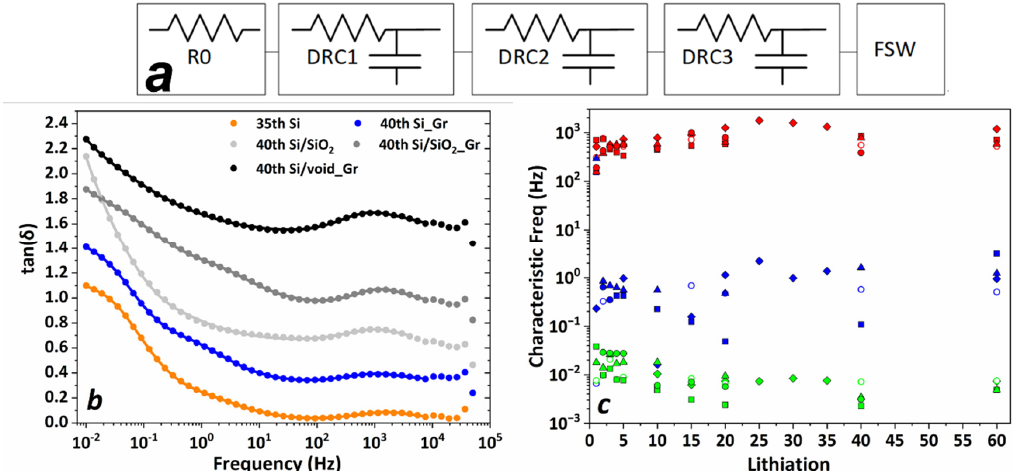
Figure 8. ( a ) Electrical response model for the description of the tan( δ ) data composed by a resistance in series with three distributed RC elements and a finite space Warburg element. ( b ) representative fitted curves (continuous lines) for the impedance data after the 40th lithiation. ( c ) Characteristic frequencies of the three peaks from tan( δ ) spectra for Si (rhombi), Si_Gr (open circles), Si/SiO 2 (squares), Si/SiO 2 _Gr (triangles), and Si/void_Gr (filled circles).